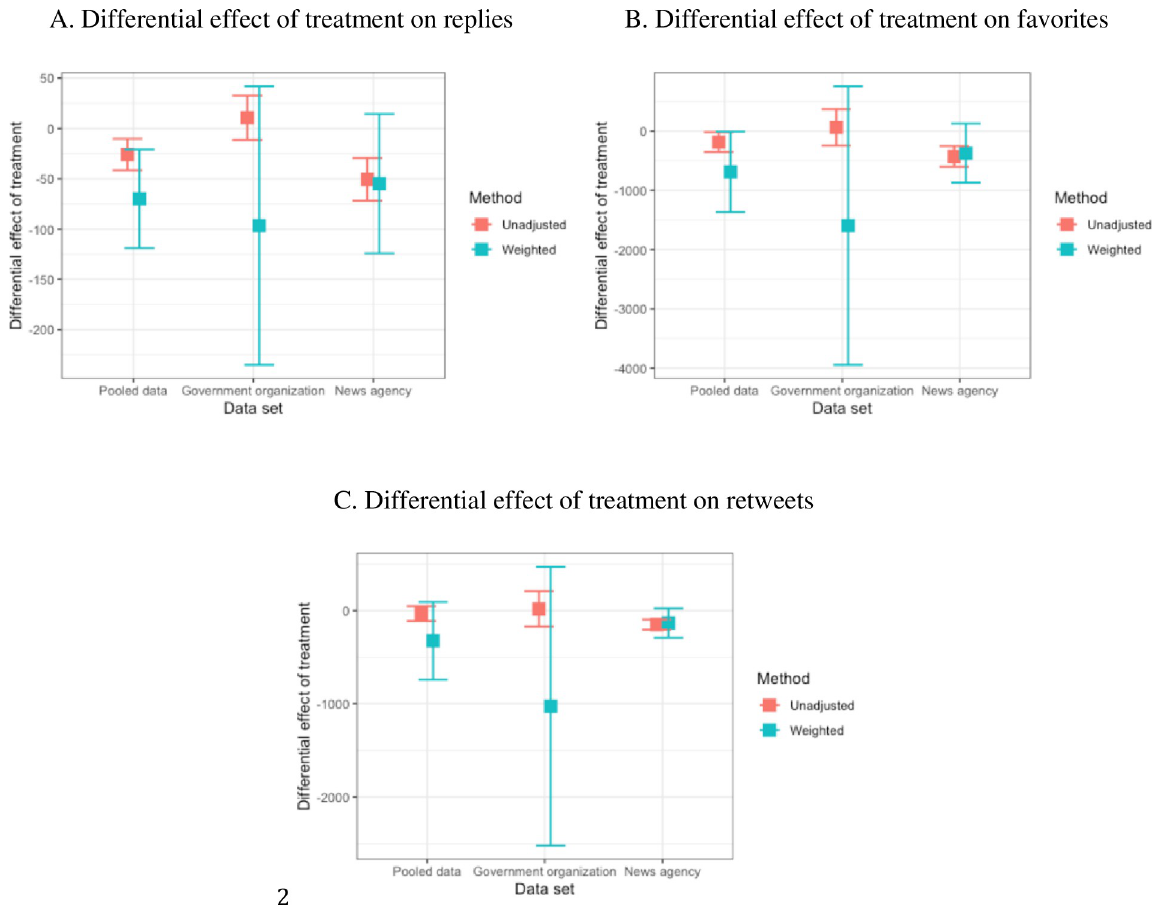
Fig 6. The differential effect of treatment on the responses (replies, favorites, and retweets) before and after justification for the covariates. The larger the absolute value of the treatment effect is, the larger the size of sentiment polarity’s impact is on the responses of the weekly tweets. The treatment effects represent the mean difference in responses to the tweets with negative sentiment and those responses to the tweets with positive sentiment from the five government organizations and four news agencies. pooled data = government organizations + news